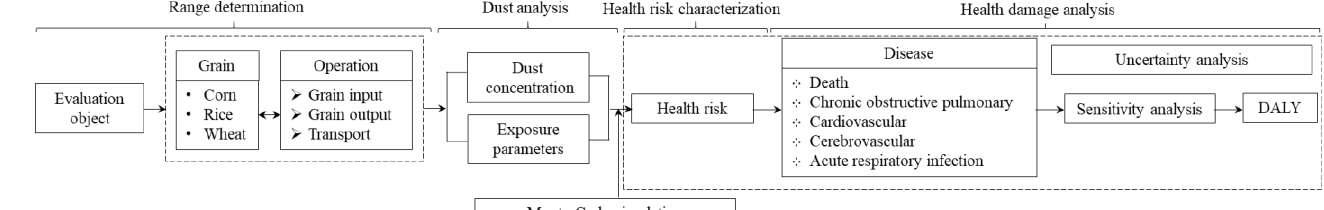
Figure 3. Dust damage model.